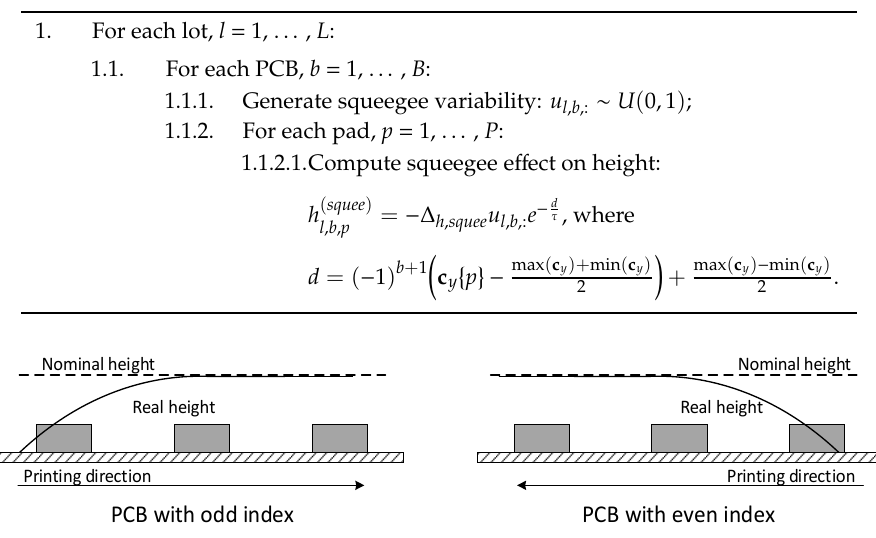
Figure 6. Schematic representation of the squeegee effect on height. Dimensions are not to scale. The final value for the height of each pad ( ( )